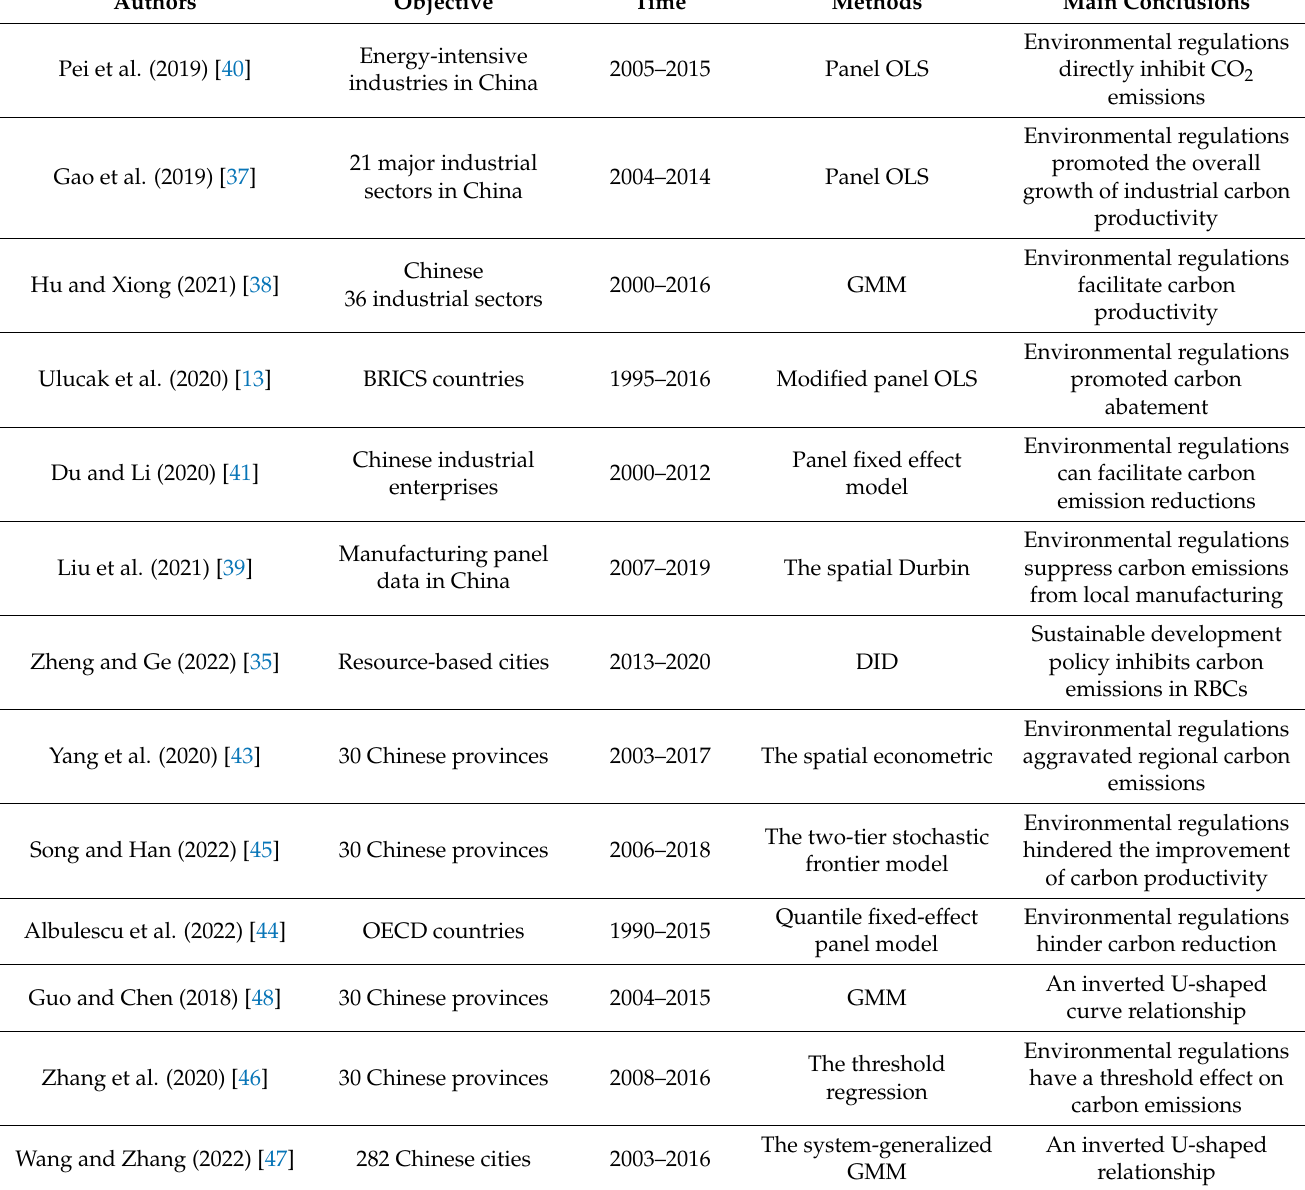
Table 1. Environmental regulations and carbon